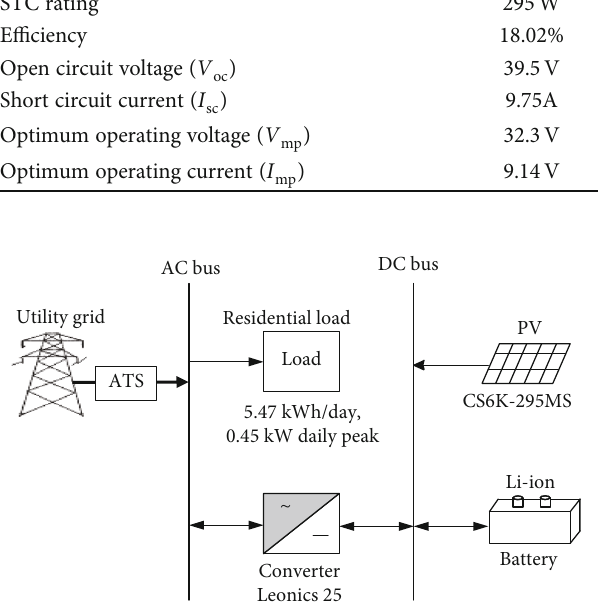
Figure 4: Layout diagram for on-grid power system with PV, battery and